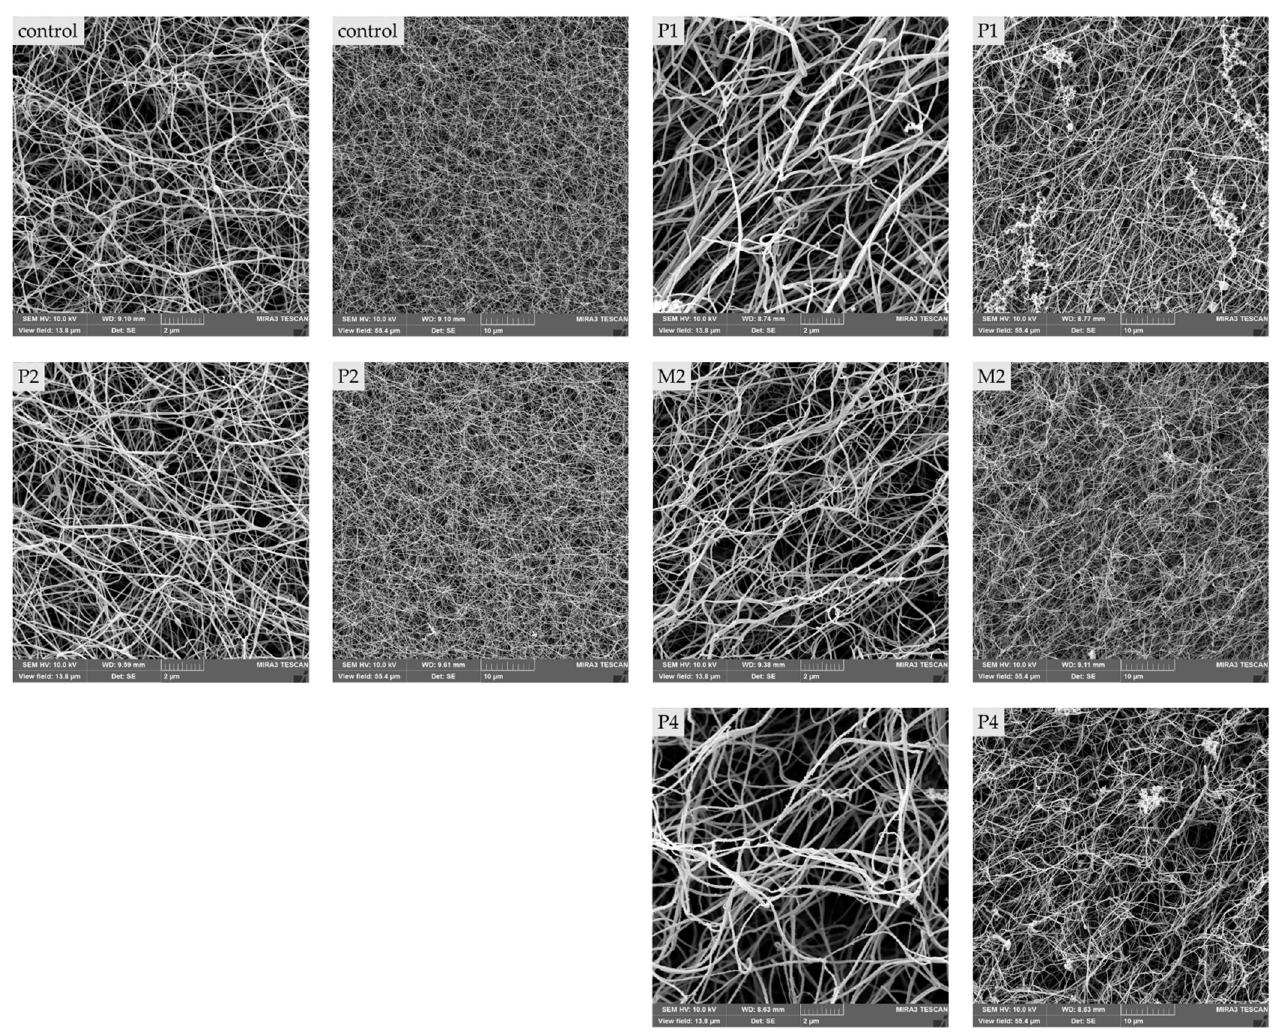
Figure 4. Representative SEM pictures of patients and control. Abbreviations: P1: patient 1; P2: patient 2; M2: mother of patient 2; P4: patient 4.